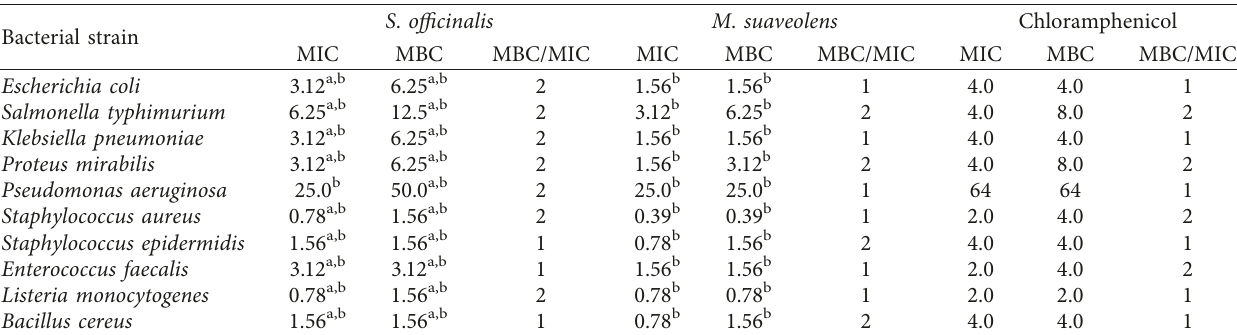
Values are the mean zone of inhibition (mm) ± SD. (–), undetected activity. a,b P < 0 . 05 vs. S . officinalis EO and chloramphenicol, respectively. Table 4: Minimum inhibitory concentration (MIC), minimum bactericidal concentration (MBC), and MBC/MIC values of the essential oils (EOs) of Salvia officinalis and Mentha suaveolens against the ten tested bacterial strains. Bacterial strain